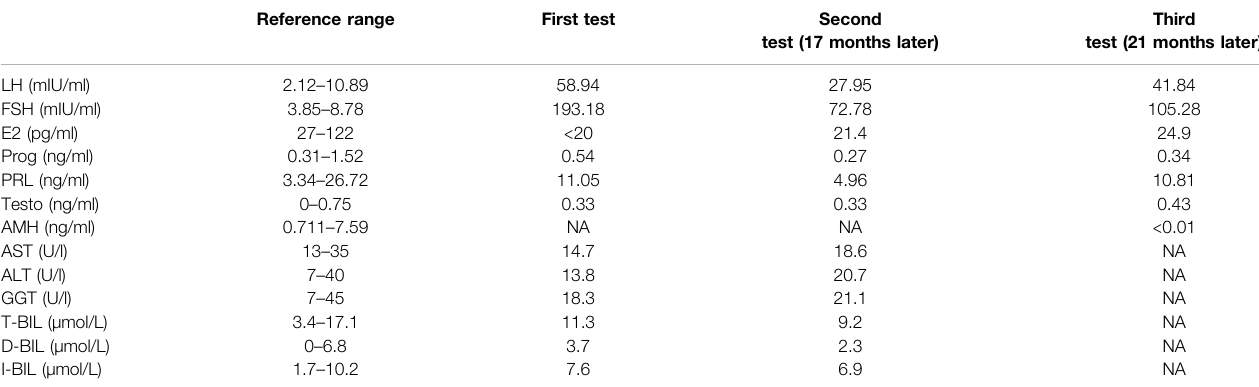
TABLE 1 | Laboratory values of various sex hormones and liver function in the patient. Reference range